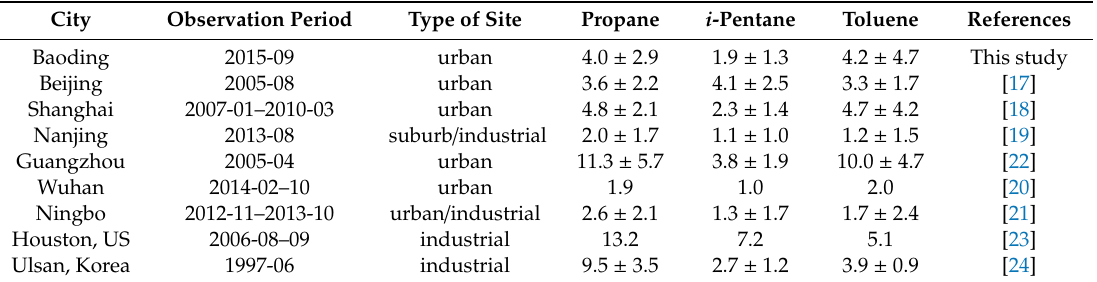
Table 1. Comparisons of propane, i -pentane, and toluene levels (ppb) measured in di ff erent cities.